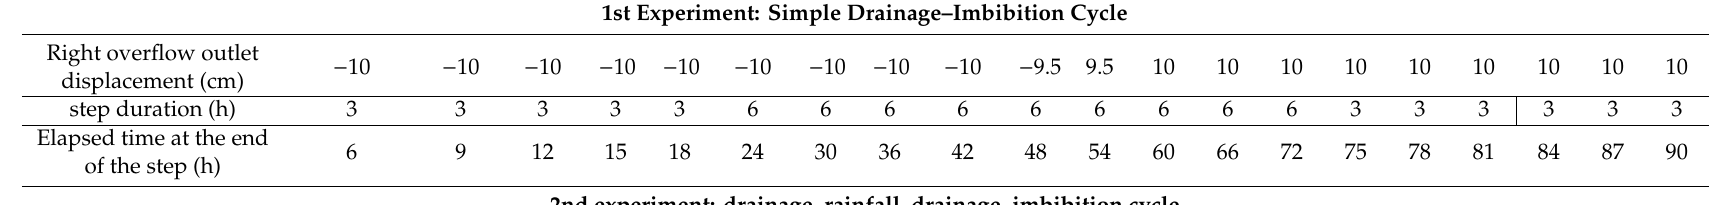
Table 1. Experimental procedure: movement of the overflow outlet responsible of transient flow in the flow chamber. 1st Experiment: Simple Drainage–Imbibition